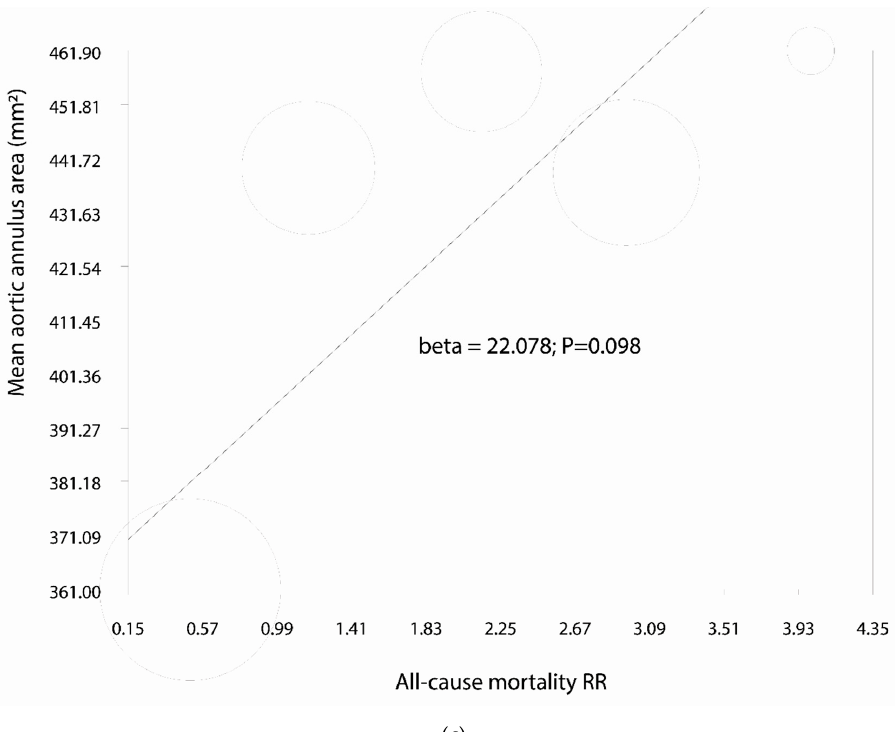
Figure 5. Individual and summary risk ratios with corresponding 95% confidence intervals for the comparison of ACURATE neo vs. SAPIEN 3 in the analysis of ( a ) 30-day all-cause mortality; ( b,c ) meta regression analyses .